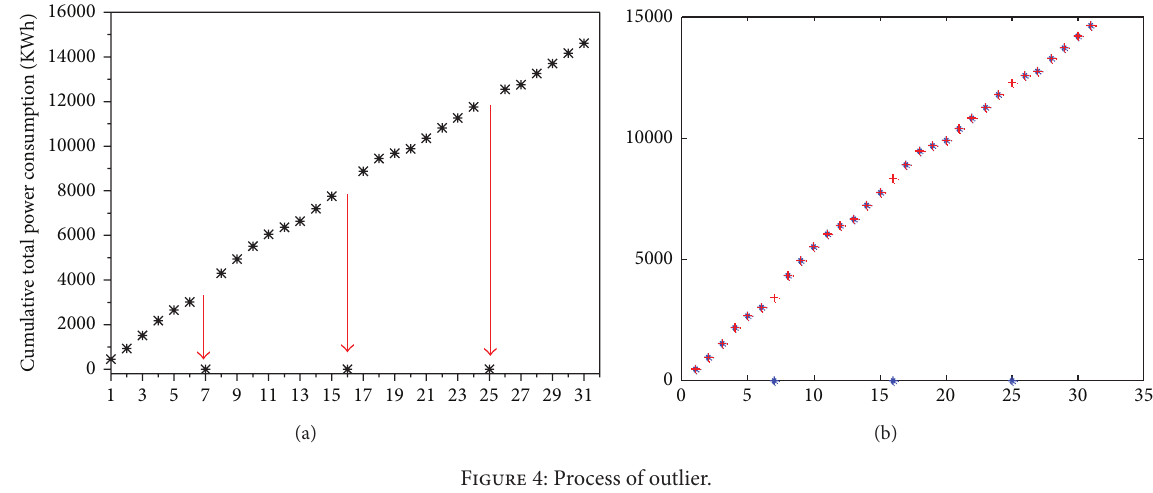
Figure 4: Process of